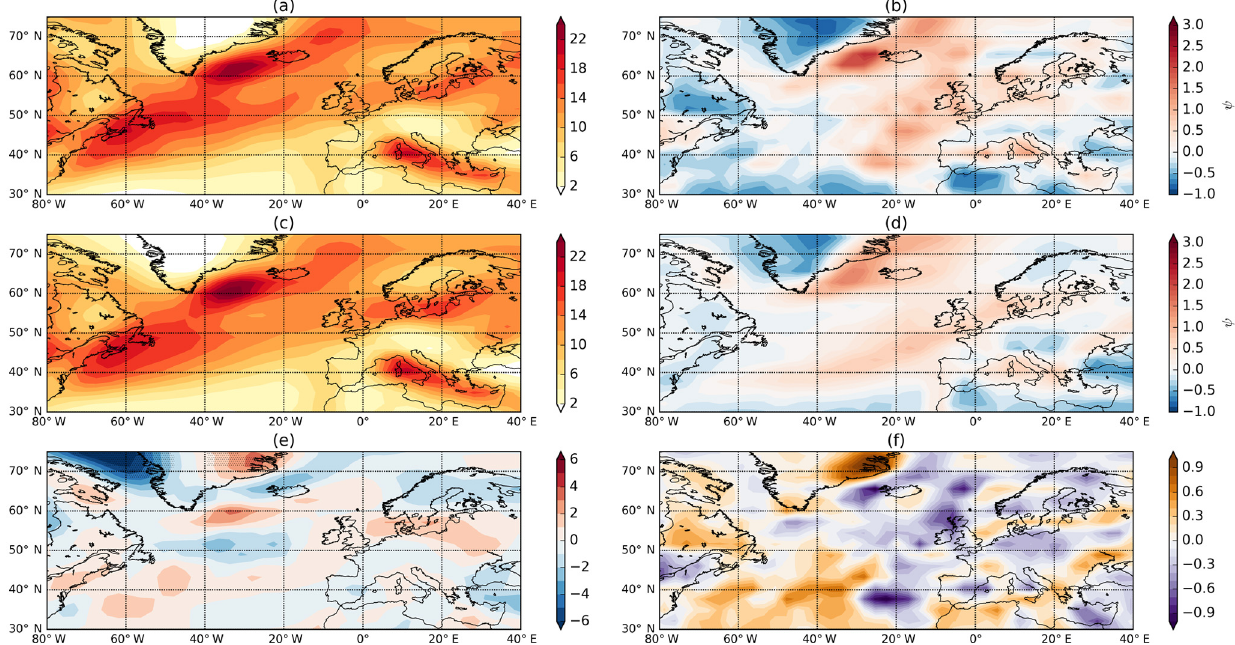
Figure 1. Track density (a) and associated dispersion (b) for ERA-Interim DJF storm track. Panels (c) and (d) are the same as (a) and (b) but for HiGEM. Panel (e) is the difference in track density (HiGEM–ERA-Interim); stippling indicates where the two datasets are different at the 95% level. Panel (f) is the difference in dispersion (HiGEM–ERA-Interim). Units for (a) , (c) , and (e) are cyclones per month per 5 ◦ spherical